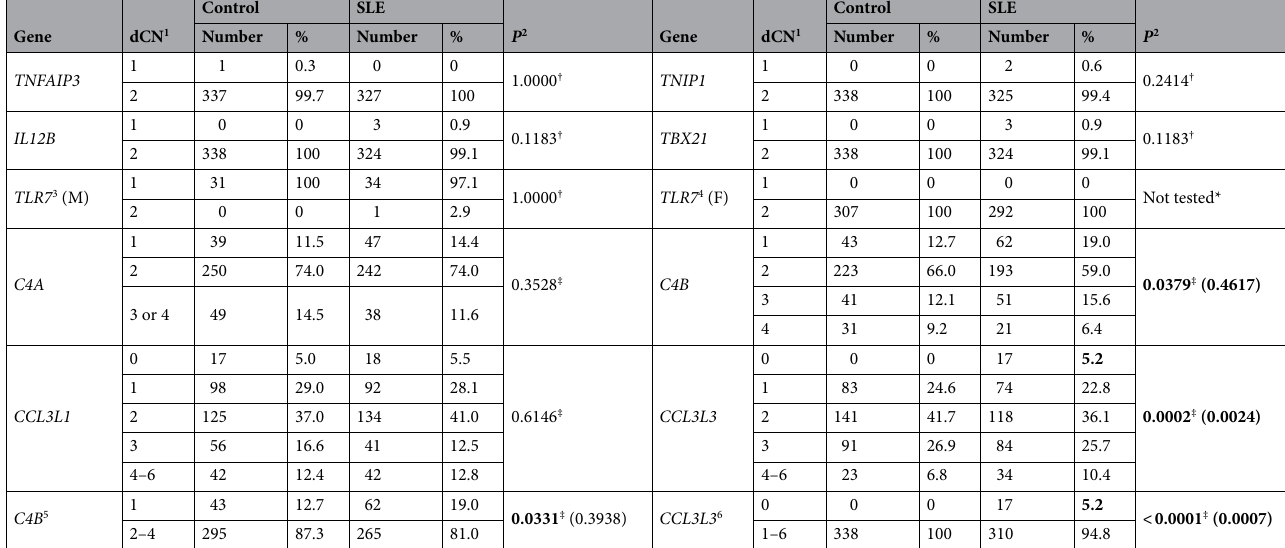
Table 1. Correlation between gene copy number and SLE. 1 dCN, digitized copy number: the standardized copy number (sCN) in which the raw copy number data were divided by half of their median value was digitized depending upon the sCN range as described in “Materials and methods”. 2 P -value was estimated by the Chi-squared test ( † ) or Fisher’s exact test ( ‡ ). Significant differences are marked by boldface. P -values adjusted for multiple testing with Bonferroni’s correction method (11 tests) are shown in parentheses. *No statistical test was performed because there was no case with a copy number of 1 for the TLR7 gene in either the SLE patients or the controls. 3 TLR7 (M), TLR7 data for males. 4 TLR7 (F), TLR7 data for females. 5 C4B and 6 CCL3L3 were analyzed for the contributions of a copy status of 1 (for C4B ) or 0 (for CCL3L3 ) to SLE susceptibility. Odds Ratios (OR) were 1.6051 for 5 low C4B CN status, and > 18.5355 for 6 CL3L3 -null status in SLE